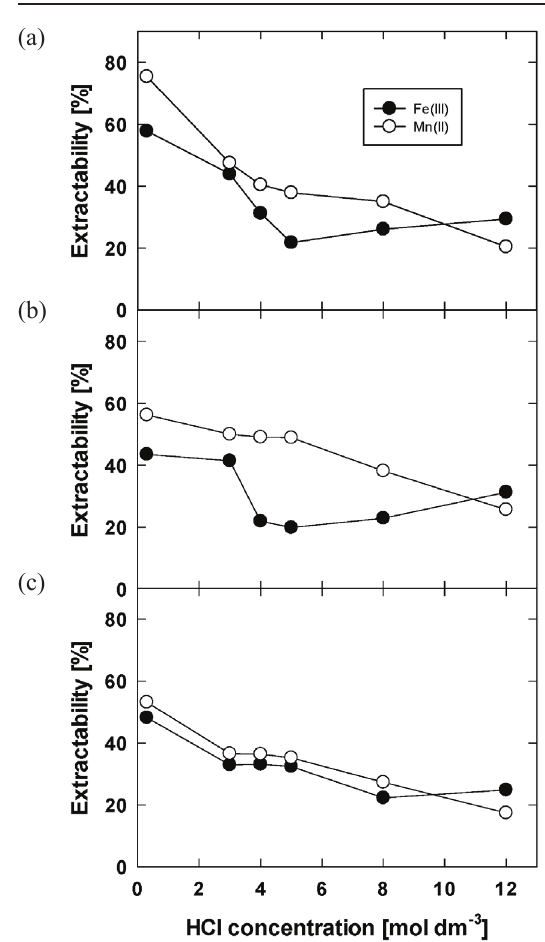
Fig. 4 – Effect of HCl concentration on extractability of Fe(III) and Mn(II) at various ratios of 50 % IL solution: 50 % PEG solution: metal solution: (a) 4: 1: 1 (b) 2: 1: 1 and (c) 1: 1: 1